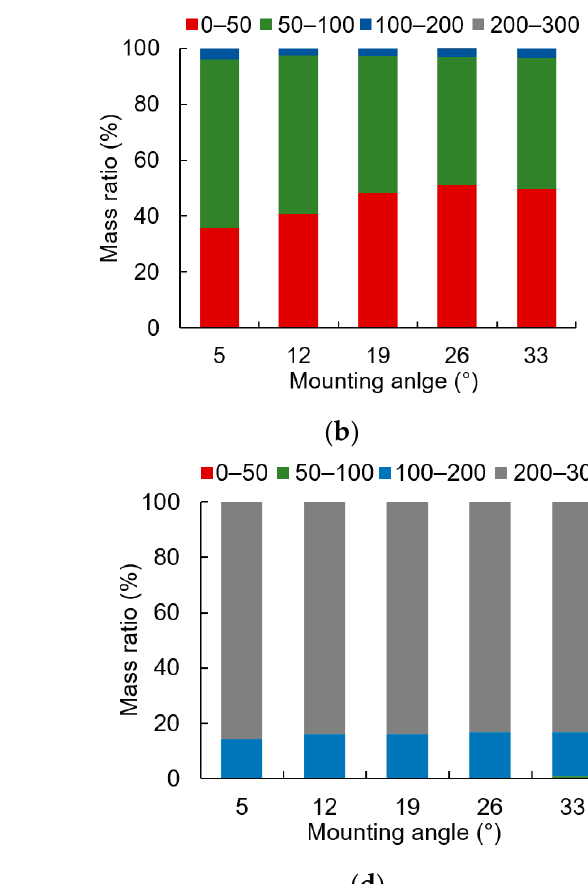
Table 2. Soil surface flatness as affected by mounting angle. Mounting Angle (°)